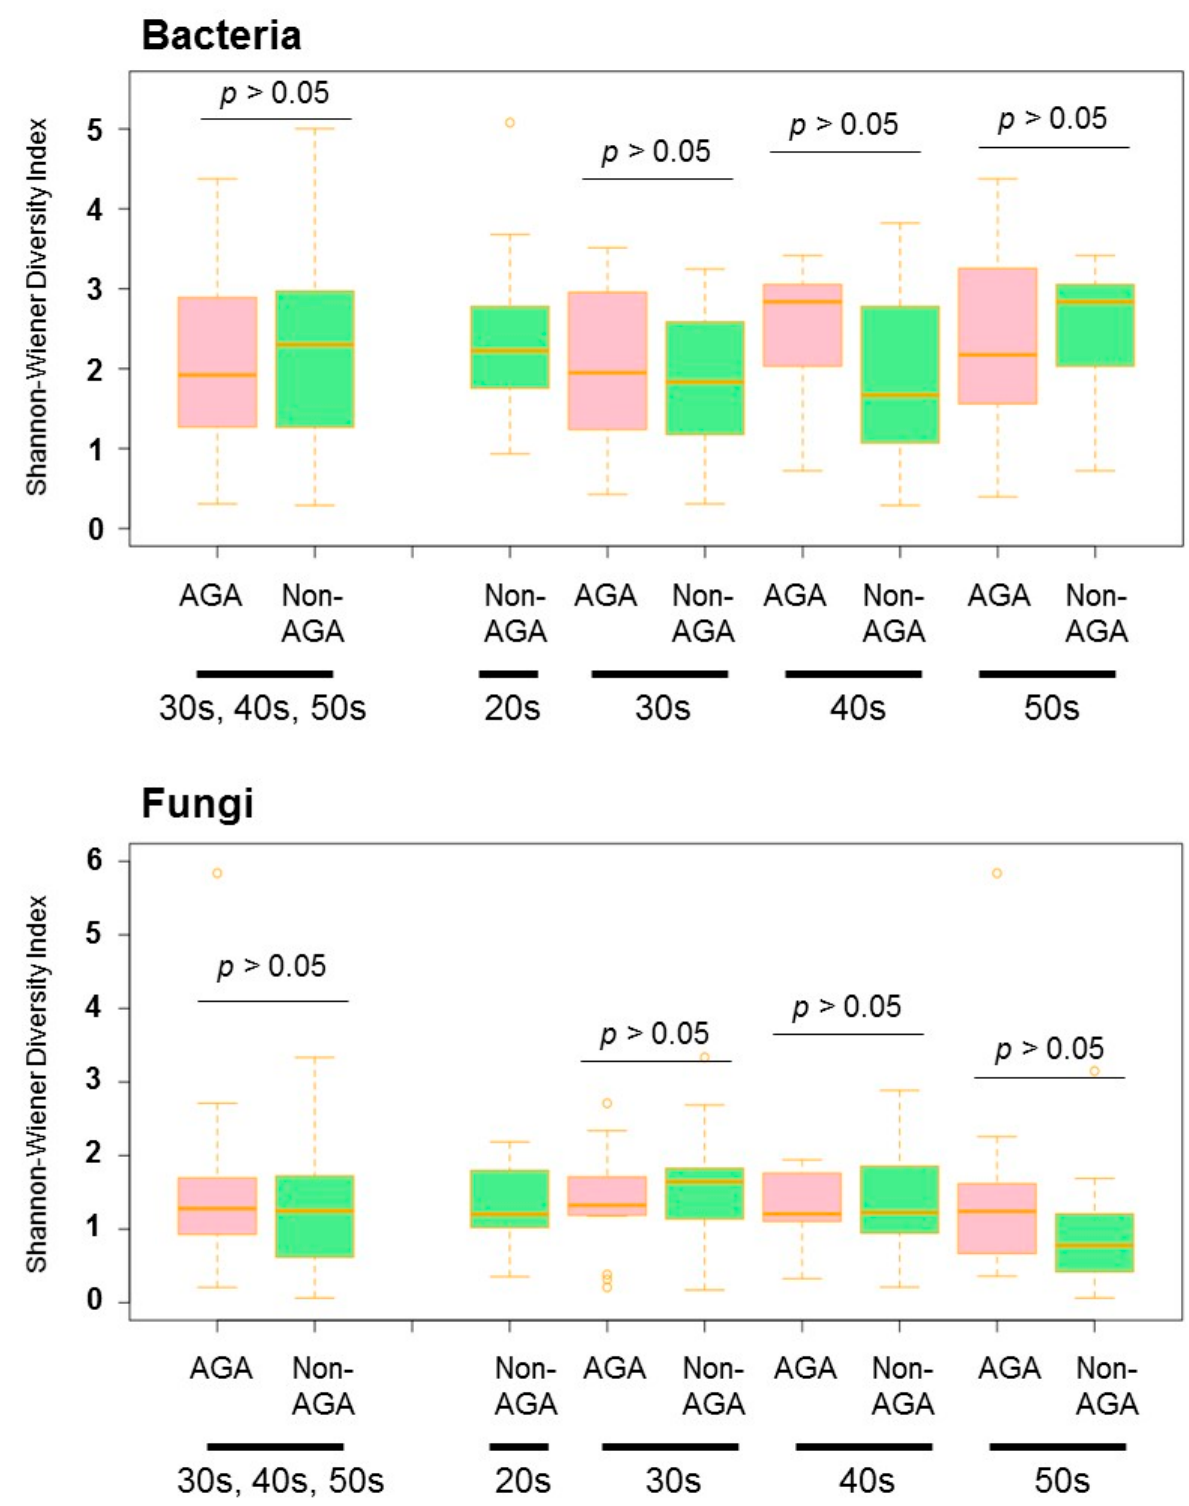
Figure 2. Shannon diversities of microbial communities among AGA and non-AGA subjects by age group (20 s, 30 s, 40 s, and 50 s).